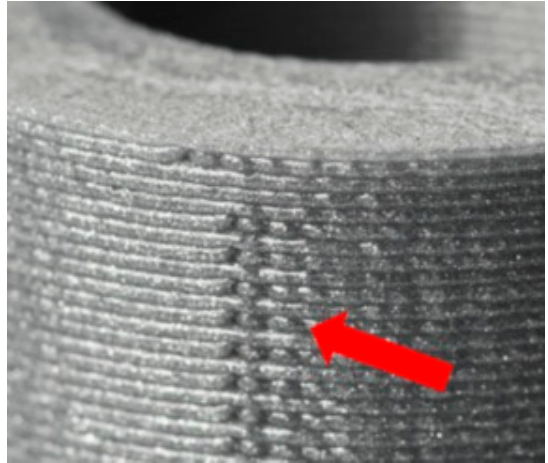
Figure 8. Imperfections are caused by the start and end of the working motion.